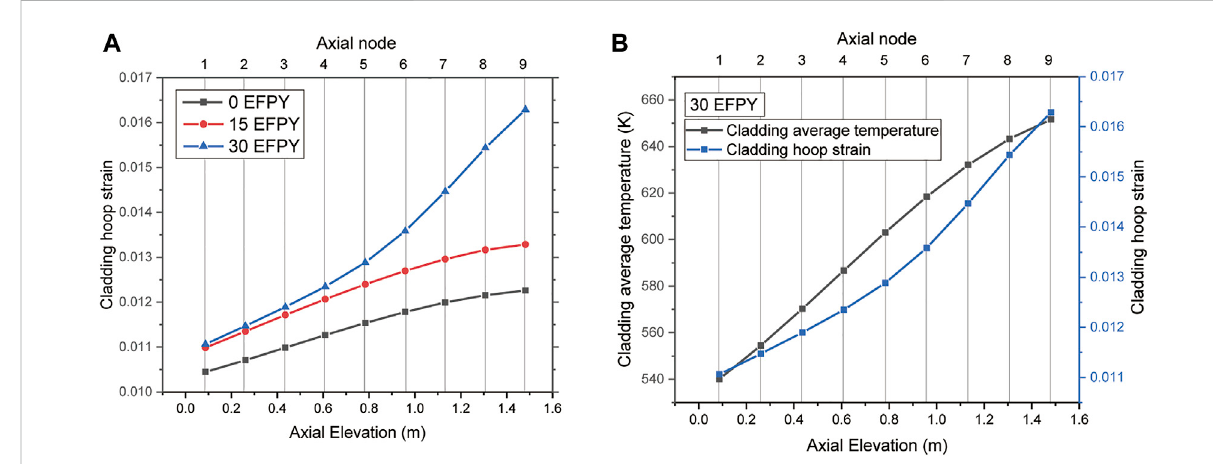
FIGURE 9 Cladding hoop strain (A) evolution pro fi le and (B) temperature relationship at 30 EFPY.